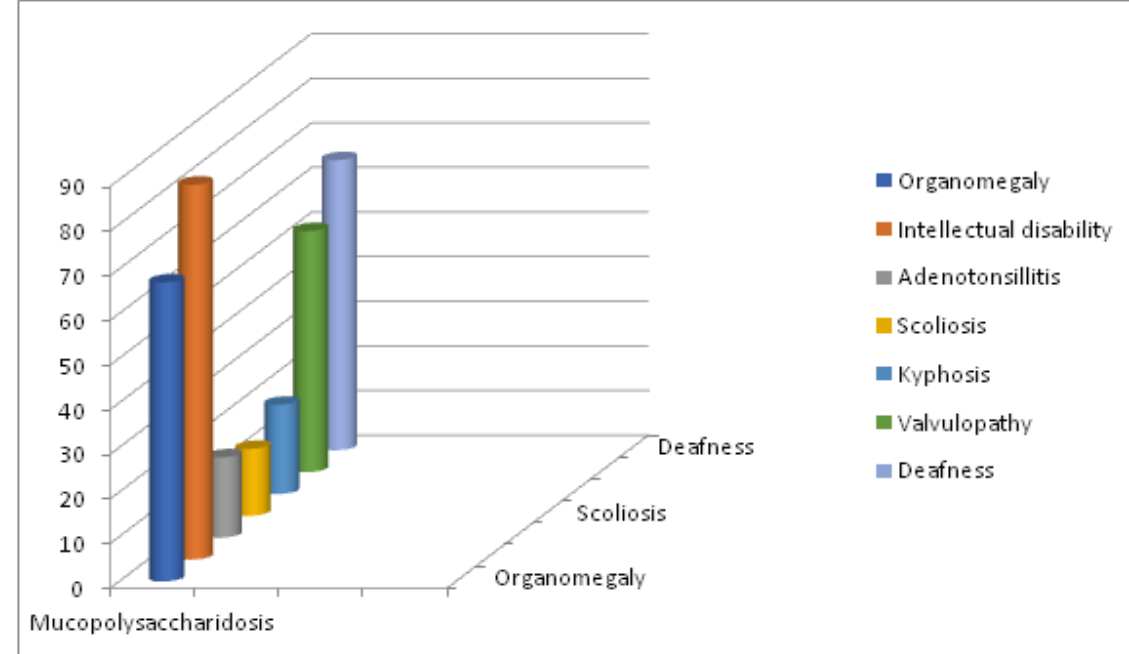
Figure 3. Results of specialist evaluation in MPS patients. Organomegaly includes hepatomegaly and splenomegaly. Valvulopathy includes aortic regurgitation (AR), mitral regurgitation (MR) and mitral valve prolapse